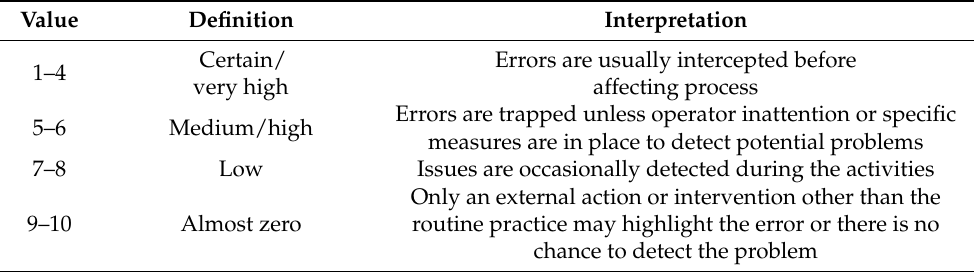
Table 3. Detection scale. 1–10 ranking correlates with the progressive decrease in the likelihood that the failure will be detected before the bioprinting process